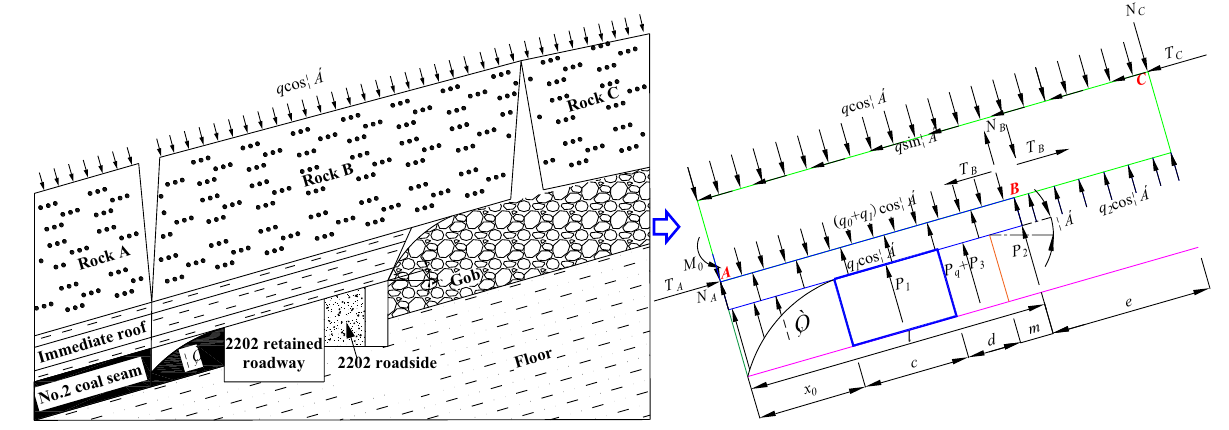
Fig. 9 Mechanical model of GER with double roadways in a gently inclined coal